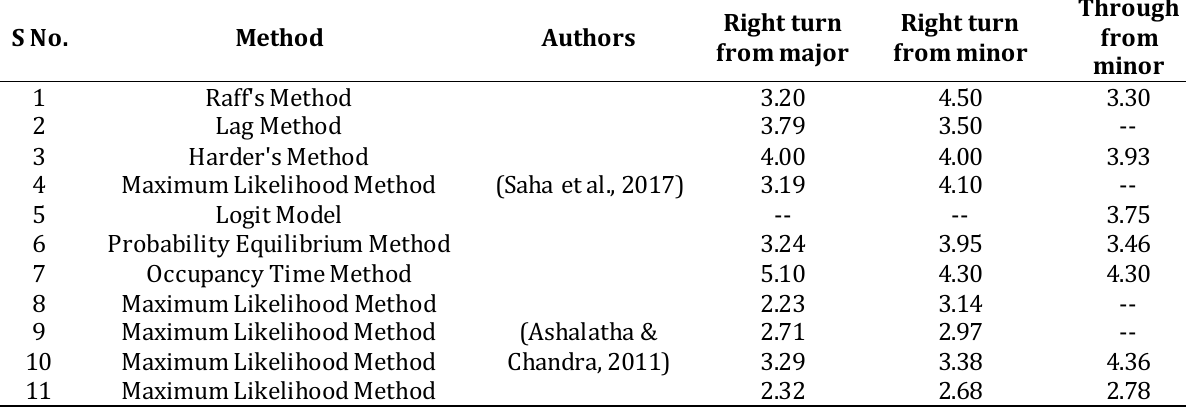
Table 6: Critical gap values for four-arm uncontrolled intersection for turning movements for heterogeneous traffic condition in developing country S